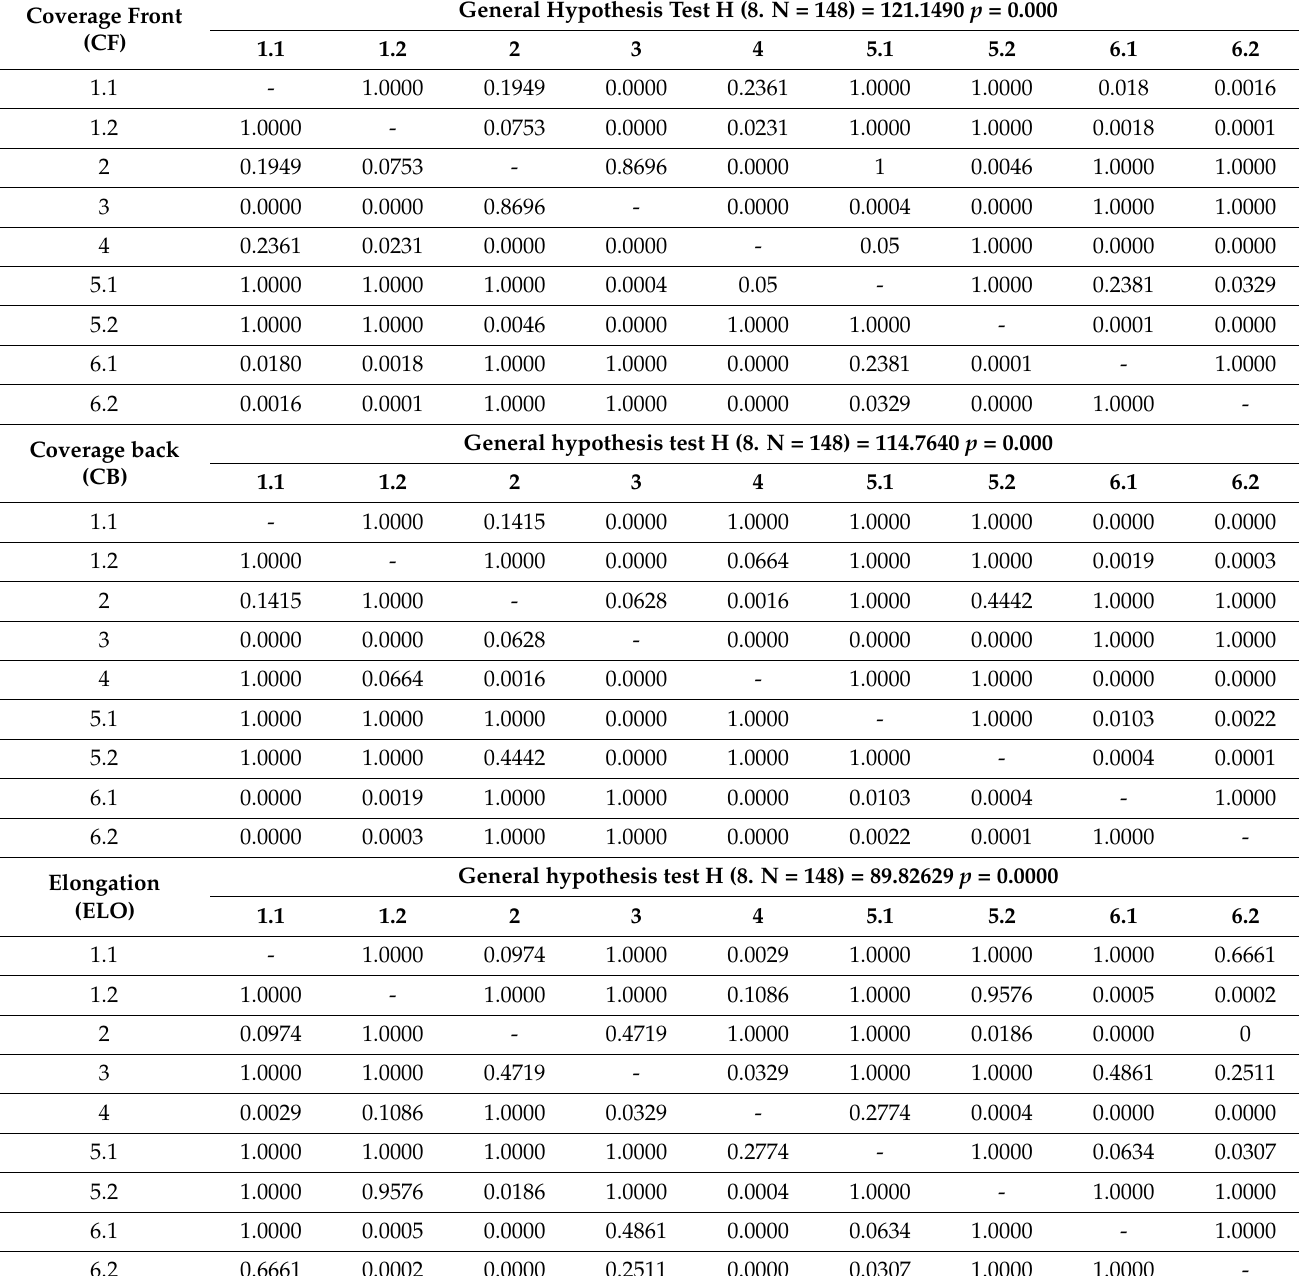
Table 7. Kruskal–Wallis test p -value for multiple (two-sided) comparisons between round baler and bulk material